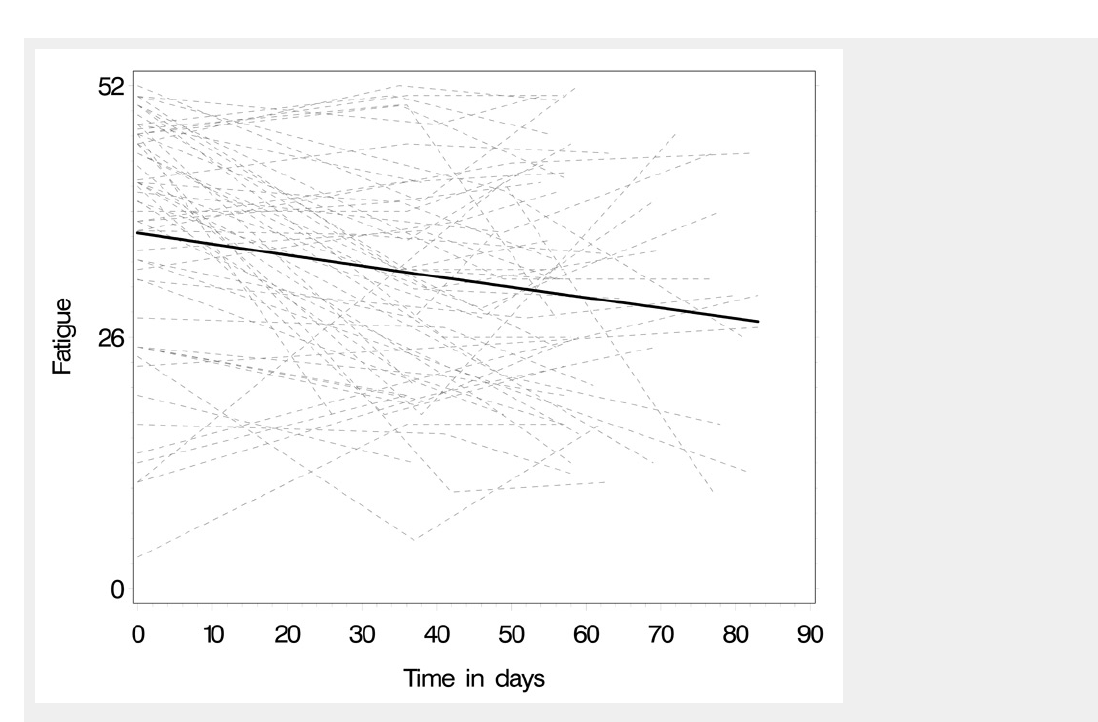
Figure 3 Predicted trend of fatigue over the three measurement points: thin lines represent patients’ individual trajectories, the thick line the average group trend. Lower scores indicate increase of